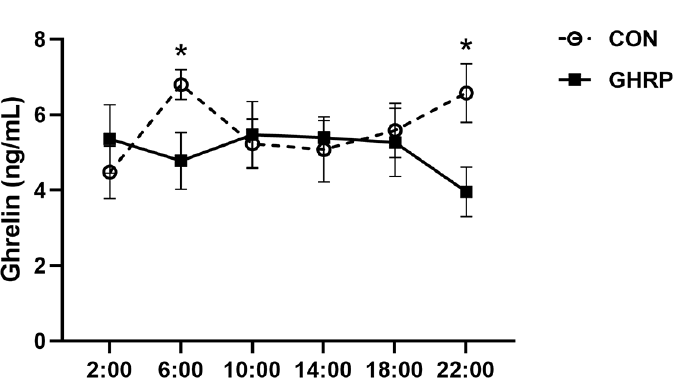
Figure 2. Changes in the level of ghrelin in serum after injection of ghrelin antagonist ([D-Lys3]- GHRP-6). The injections were performed at 8:00 and 13:00. Values are means ± SEMs; n = 6. * p < 0.05 versus control group. CON: injection of saline; GHRP: injection of [D-Lys3]-GHRP-6.